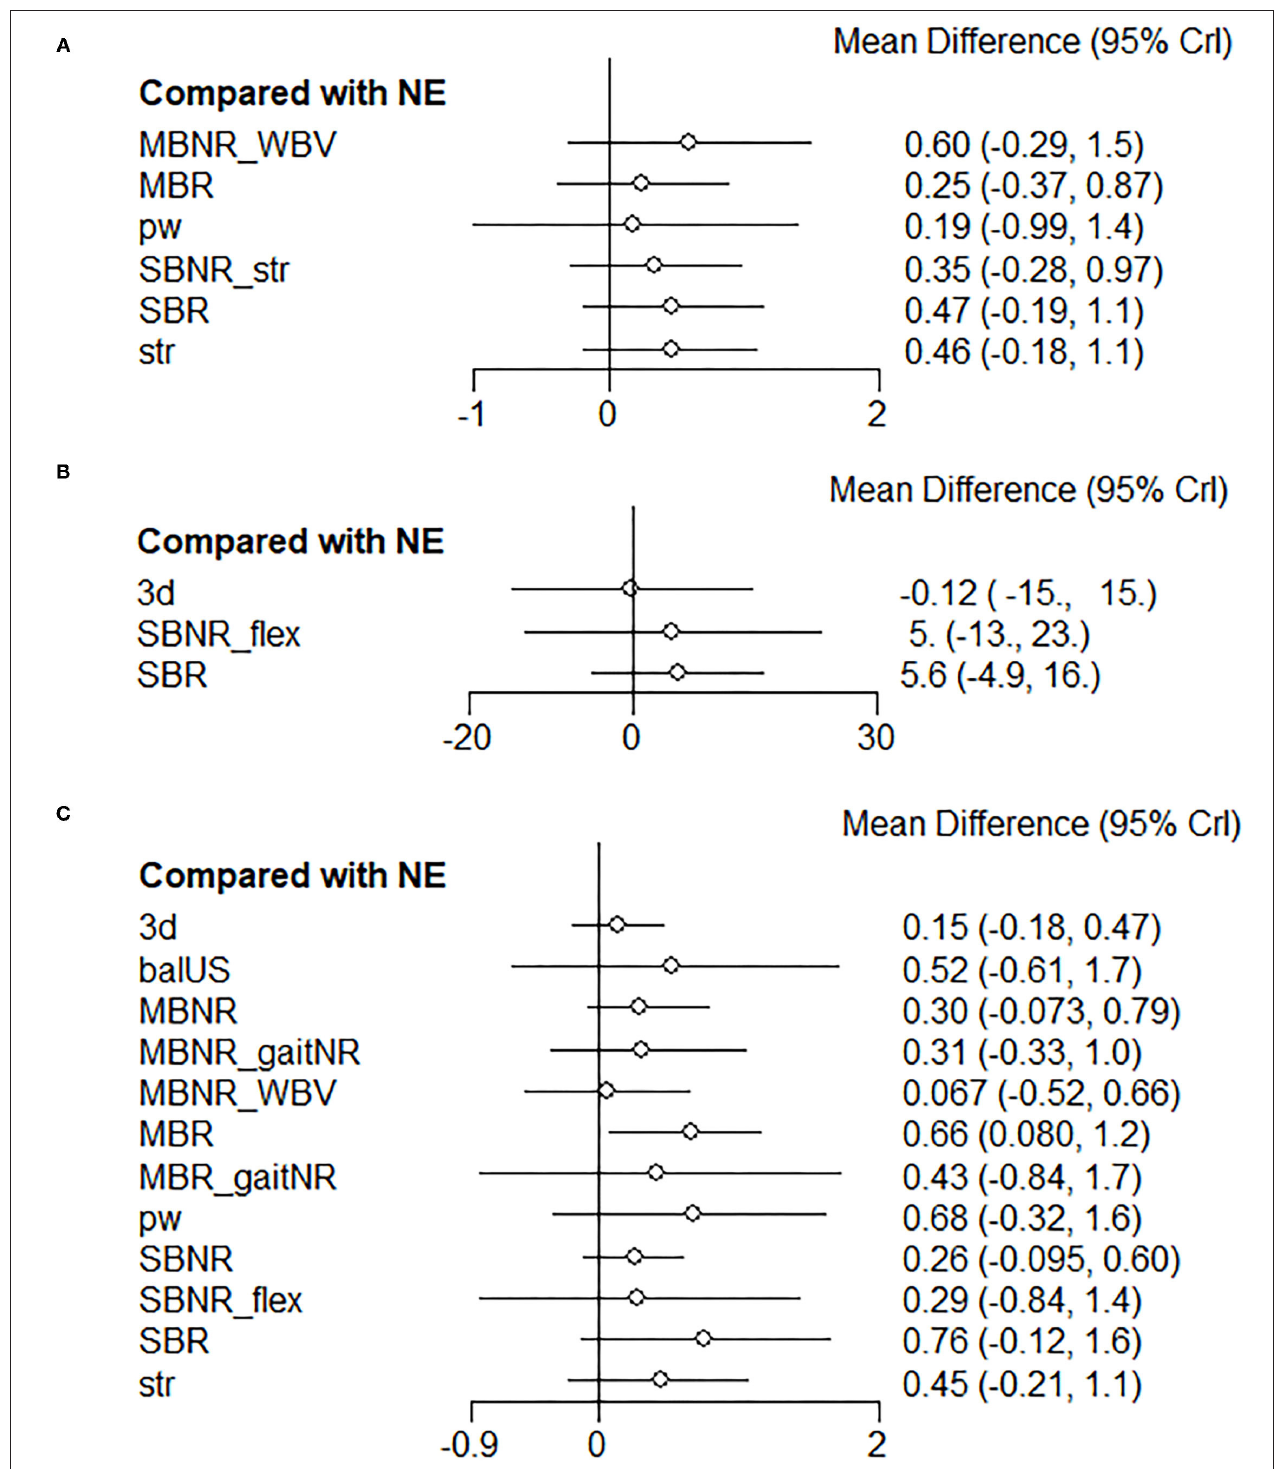
FIGURE 9 | Forest plots of the relative effects of exercise interventions with a no-exercise as a reference group in each reactive balance outcome category. (A) Simulated forward falls, (B) Being pushed or pulled, and (C) Movable platform. SBR, Single balance exercise including reactive balance component; SBNR, Single balance exercise not including reactive balance component; MBR, Multiple balance exercises including reactive balance component; MBNR, Multiple balance exercises not including reactive balance component; WBV, Whole body vibration; str, Strength; pw, Power; 3d, 3D exercise; NE, No exercise.